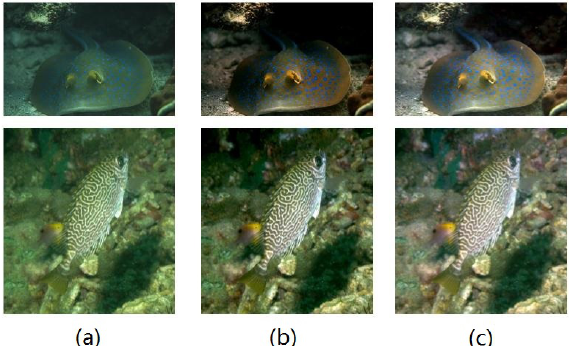
Figure 7. The comparison results. ( a ) underwater images; ( b ) the restored images based on the dataset generated without the modified ambient light distribution; ( c ) the restored images based on the dataset generated using the modified ambient light